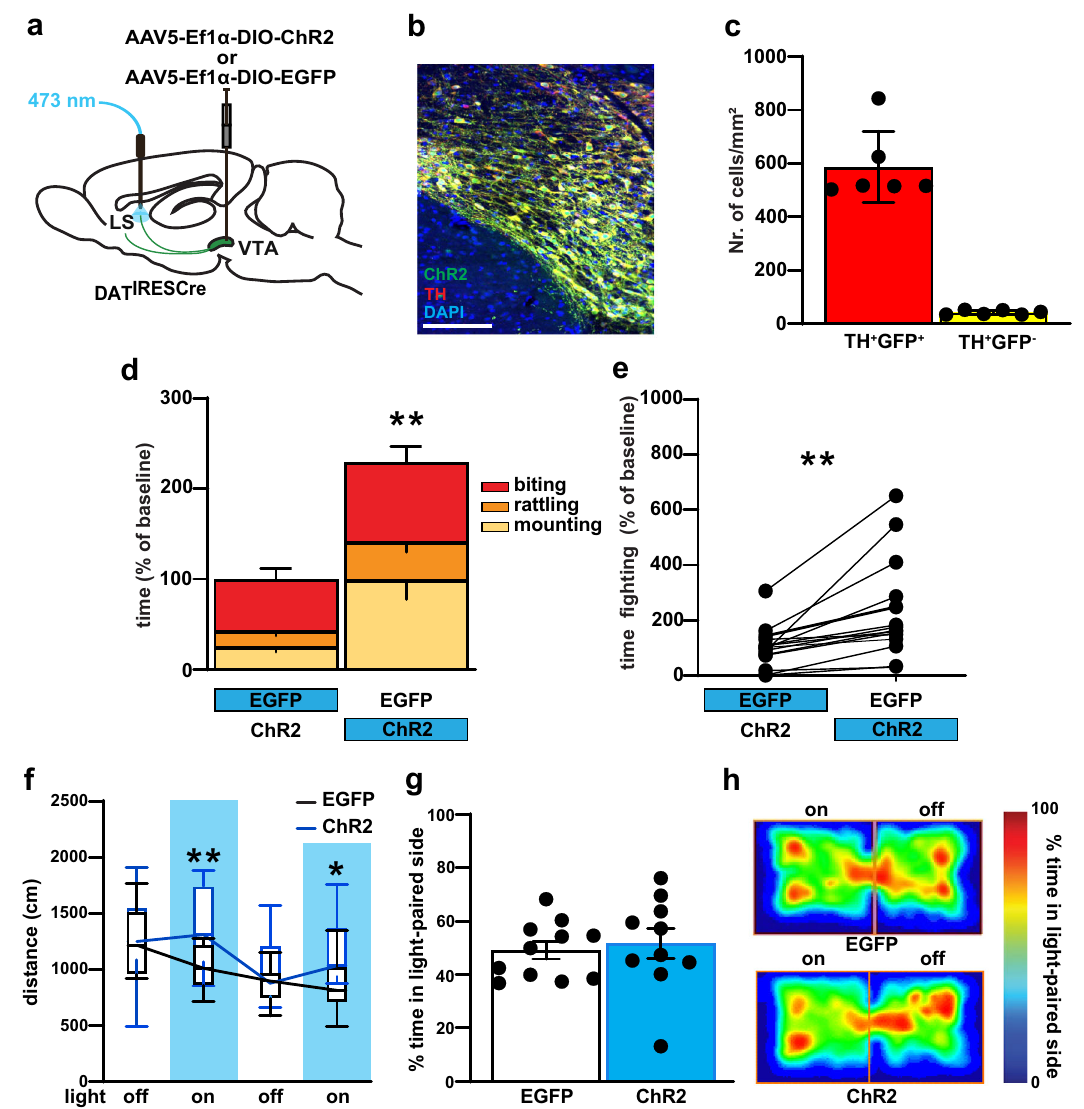
Fig. 4 Optogenetic activation of VTA → LS DAergic terminals leads to increase aggression. a Schematic diagrams for viral injection in DAT IREScre and terminal blue light stimulation in vivo. b Representative images of cell type-speci fi c AAV-DIO-ChR2-eYFP expression (green) in VTA DA neurons (red), with colocalized neurons in yellow, Scale bar, 100 μ m. c Quanti fi cation showed highly signi fi cant ChR2 expression in the TH + cell. d , e The increased aggressive response was observed in pairs when DAT IRESCre mice were stimulated (blue) in LS DA terminals. f LS DAergic terminal stimulation increased locomotor activity in the open fi eld, during alternating 3 min off and on bouts of 20 Hz stimulation only in DAT IRESCre ChR2 expressing mice. Vertical blue shading indicates optogenetic activation of ChR2. g During the RTPP task, percentage of time, over a 20 min session, spent in the stimulated zone was not signi fi cantly different in EYFP and ChR2 expressing mice. h The same result also displayed in the representative heat maps of the time spent in the stimulated zone of the chamber during RTPP. P < 0.01; *** P < 0.001 compared with their respective controls; mean ± SEM; n = 15 pairs, Box plots represent median and IQR and whiskers extend to maximum and minimum values ( f ). (Supplementary Data 1 for detailed